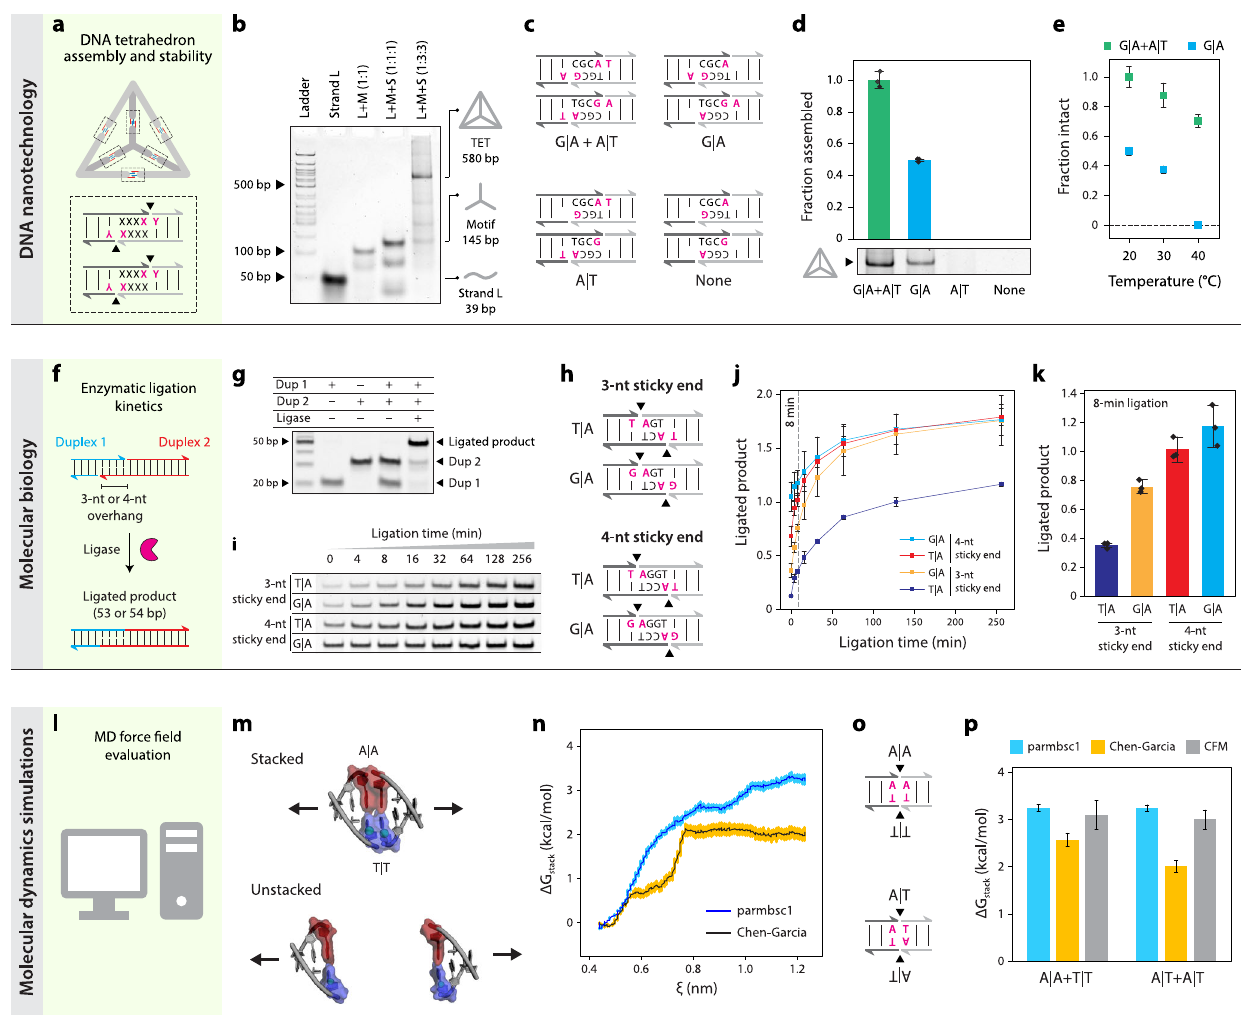
Fig. 6 | Base-stacking in biotechnology applications. a A DNA tetrahedron is assembled from four 3-point-star DNA motifs connected on each edge with two pairs of sticky ends. b Non-denaturing PAGE analysis shows DNA tetrahedron assembly from oligonucleotide components. (n=1). c Designs of base stacking interactions tested in DNA tetrahedra with conserved sticky end sequences. d AssemblyofDNAtetrahedrawithdifferentbasestacks(fullgelsinSupplementary Fig.14). e ThermalstabilityofDNAtetrahedrawithvariousbase-stacks. f Ligationof two DNA duplexes with 3 or 4 base pair sticky ends. g Non-denaturing PAGE con- fi rms the ligation of the two DNA duplexes (full gel in Supplemental Fig. 15) ( n =1). h Designs of base stacking interactions of sticky ends tested for ligation. i Gel images show the increase in band intensity of ligated fragments (full gels in Sup- plementary Figs. 16 – 17). j Quanti fi ed ligation productover time. k Ligated